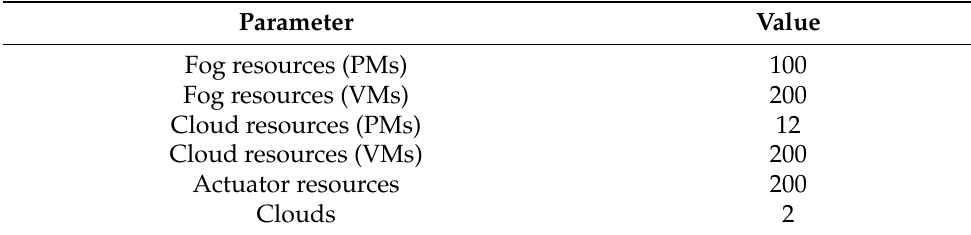
Table 6. Requirement of resources used in the evaluation